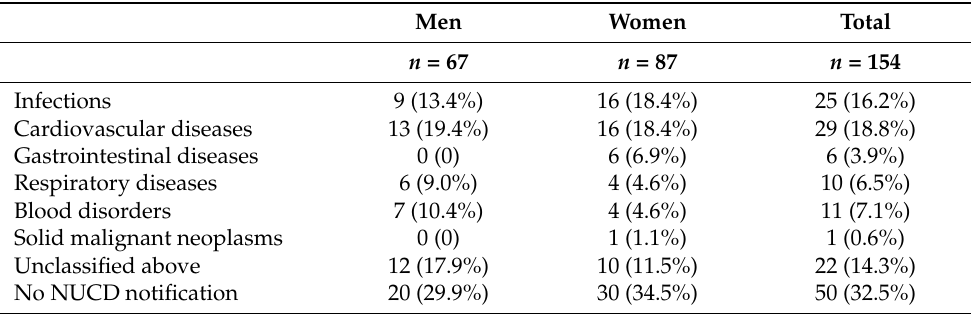
Table 2. Non-underlying causes of death when SD was listed as the underlying cause of death, for the period 1979–2016.